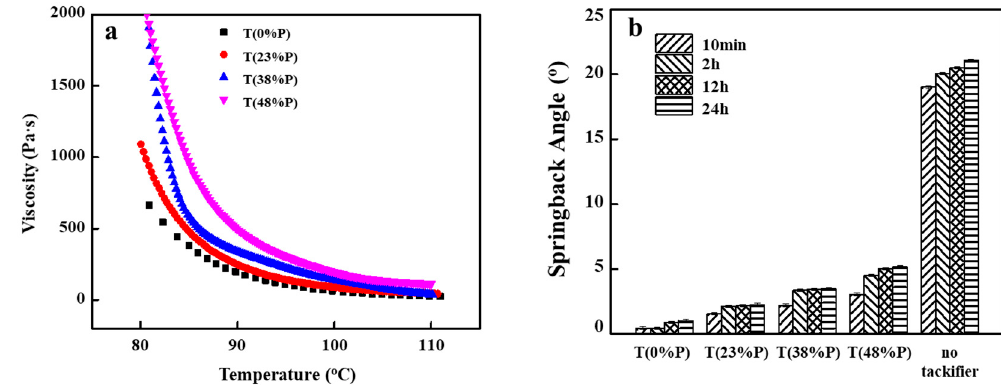
Figure 1. ( a ) Temperature dependence of complex viscosities for the ET3228 tackifiers with microencapsulated red phosphorus (MRP) contents ranging from 0 to 48 wt.%. ( b ) Springback angles monitored for the fabrics preformed by 0–48 wt.% MRP-loaded ET3228 tackifiers and the fabric without preforming. All the t-tests carried out on the springback angles of the fabrics preformed by different tackifiers resulted in a p value less than 0.01, indicating that the dependence of the springback angle on MRP content is statistically significant.